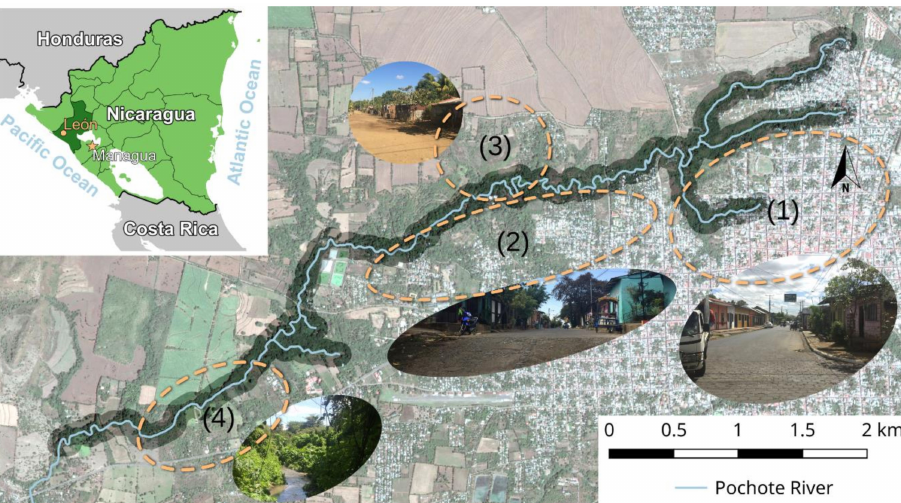
Figure 1. Overview of the study area: Pochote River and City of Le ó n [4], areas indicated with dashed lines and corresponding photographs (1)–(4) illustrate landscape characteristics in the surroundings of the river corridor: (1) historical formally and densely urbanized regions, (2) informal urban–rural transitional regions, (3) recent formal rural settlements, and (4) a less disturbed downstream section of the river